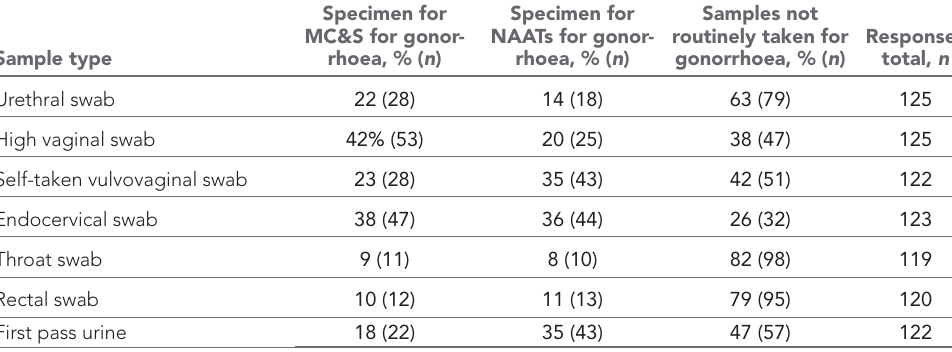
Table 3 Responder answers to the question ‘What sample types do you routinely take for